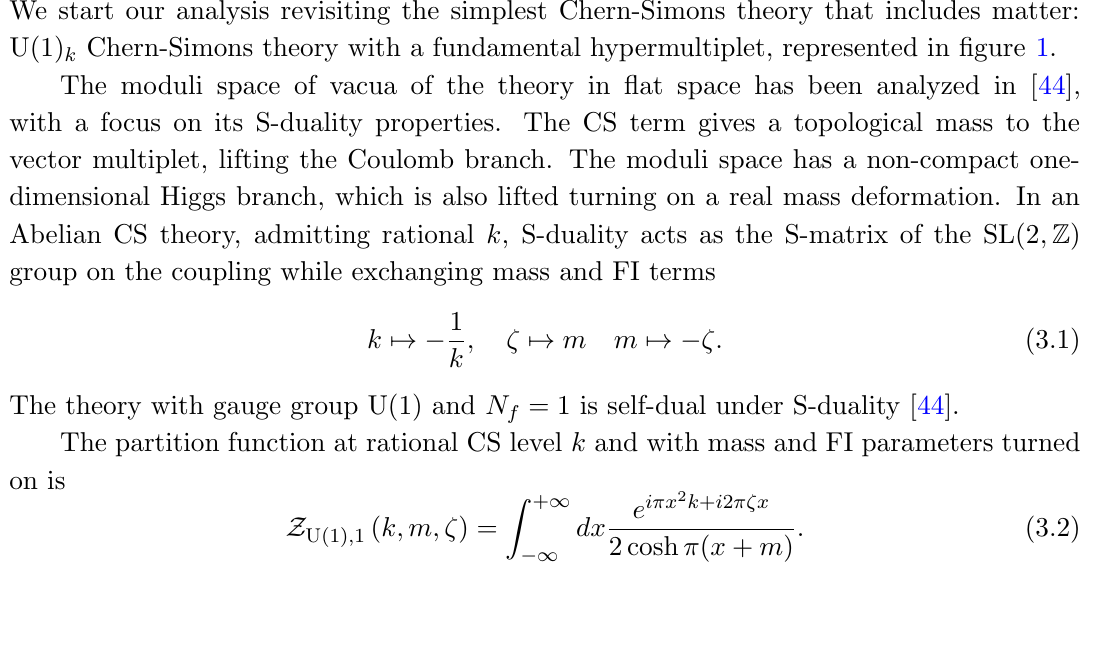
Figure 1 . U(1) k theory with N f = 1 fundamental (cid:13)avour. This is an Abelian A 1